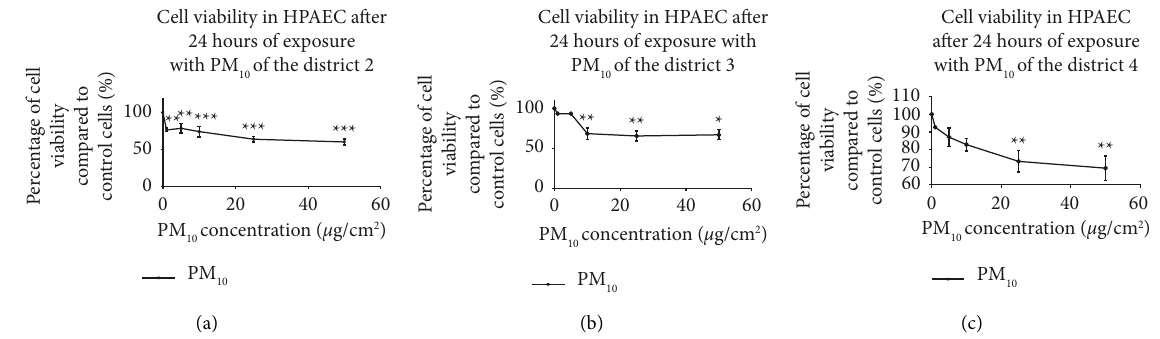
Figure 1: Effects of PM 10 from districts 2 (a), 3 (b), and 4 (c) of Ouagadougou (Burkina Faso) on the HPAEC cell viability after 24 hours of exposure. The HPAEC cells were seeded at 20,000 cells/cm 2 and then intoxicated or not for 24 hours at different concentrations of PM 10 (1.5, 10, 25, and 50 µ g/cm 2 ). Cell viability was measured by the WST-1 assay. Percent cell viability was calculated relative to control cells (100%). Data are expressed as means ± the standard error of the mean (SEM) of three independent experiments n � 3 (three wells/concentration). The statistical test used is a one-way ANOVA followed by a multiple comparison with Dunnett’s correction ∗ p < 0 . 05, ∗∗ p < 0 . 01, and ∗∗∗ p < 0 . 001: significance level compared to control cells.